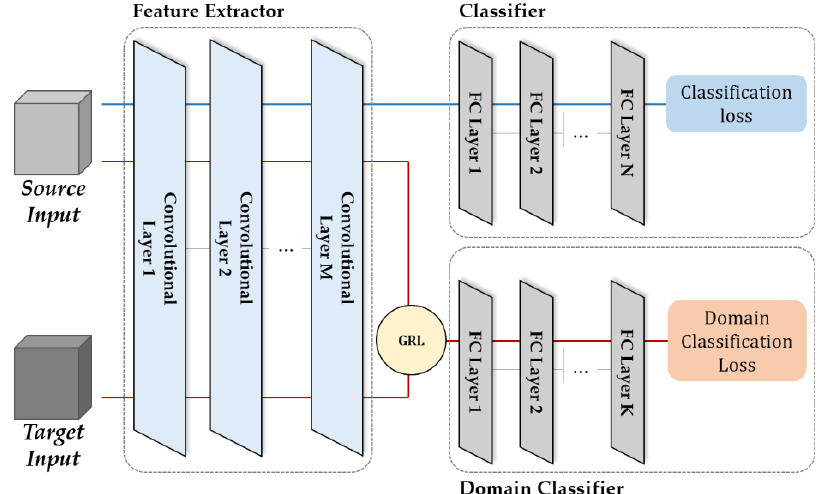
Figure 5. The architecture of domain-adversarial neural network (DANN) domain adaptation.